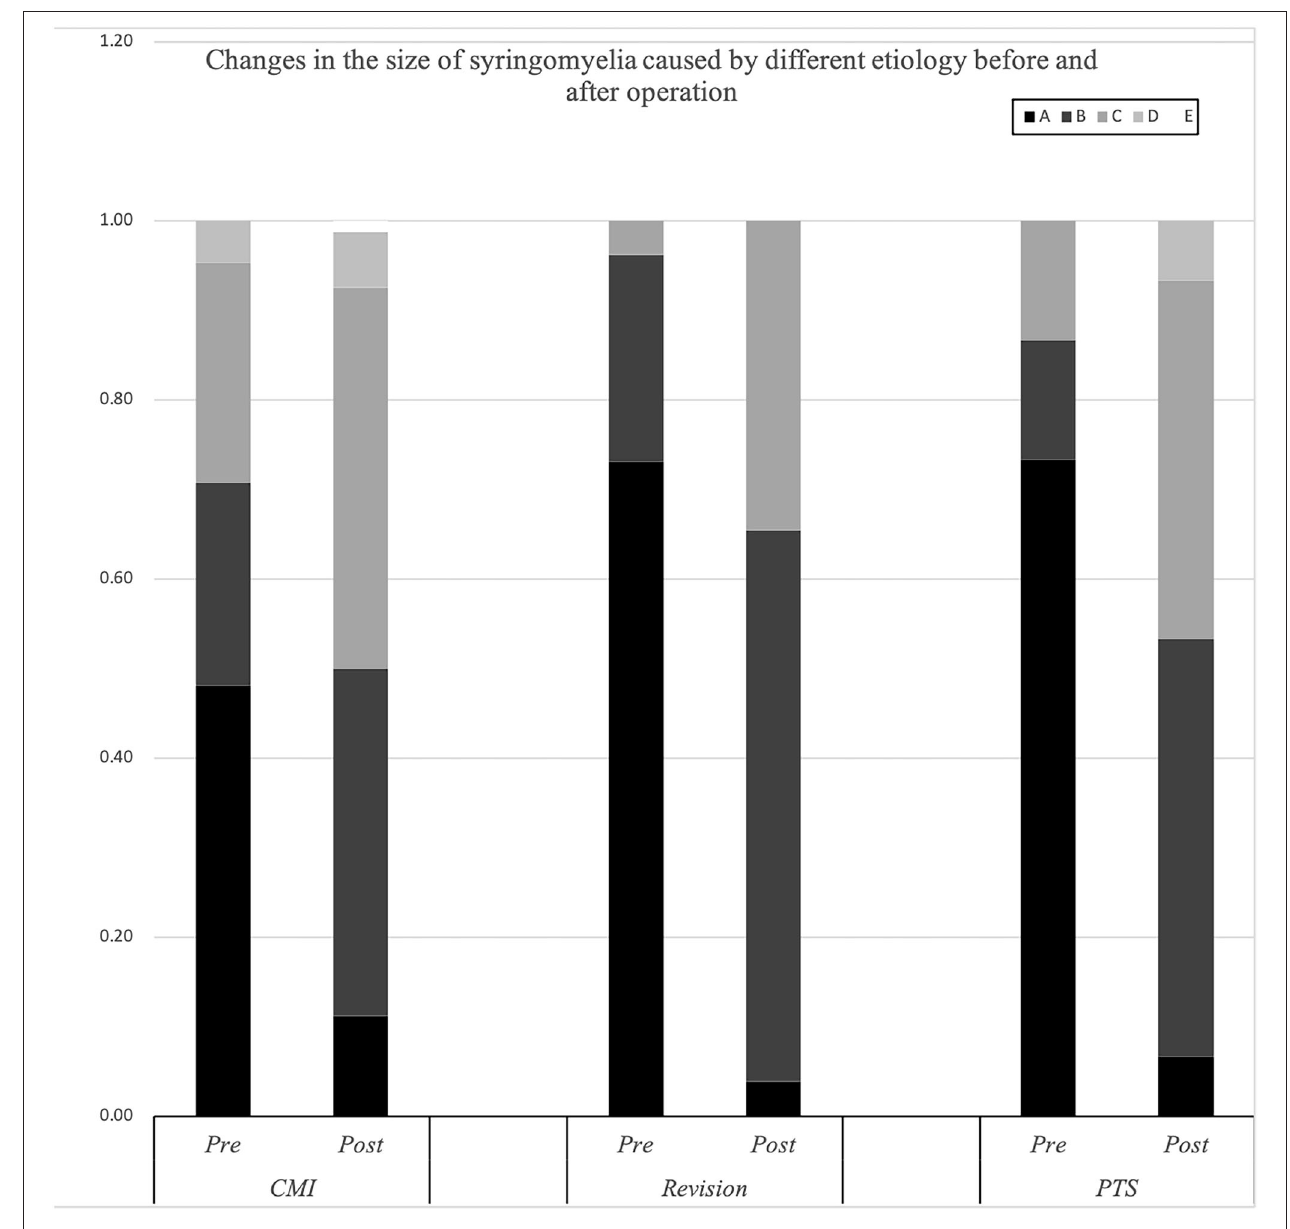
FIGURE 3 | Changes in the size of the syrinx in syringomyelia of different etiologies before and after